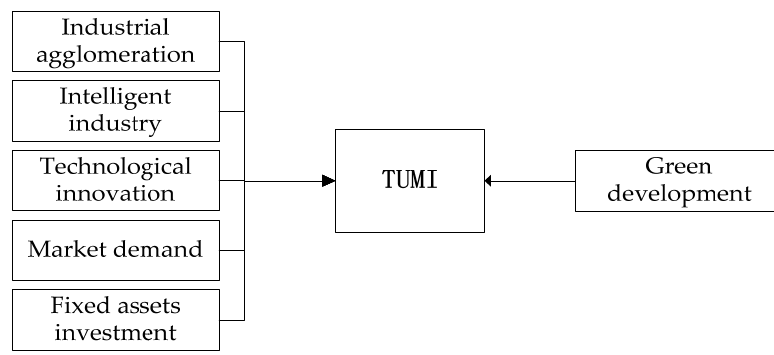
Figure 1. The macro factors of TUMI. Table 1. The macro factors for TUMI.